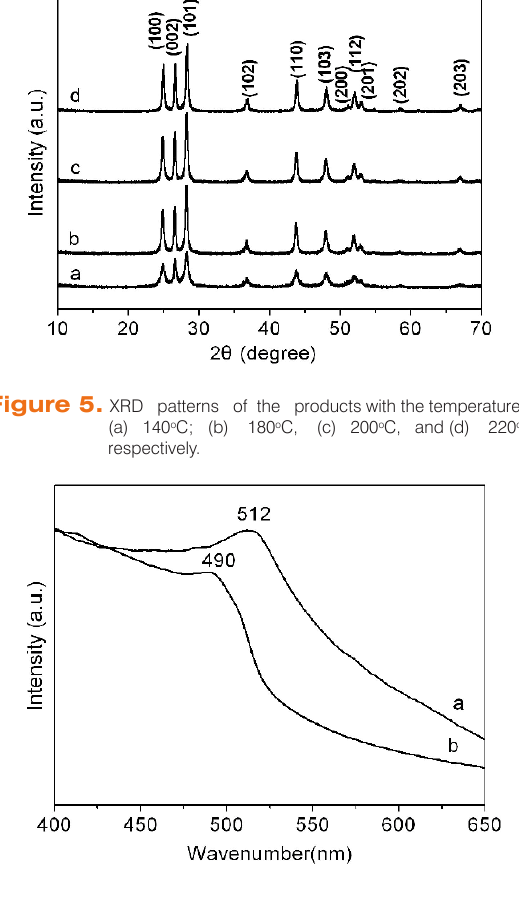
Figure 6. UV–vis absorption spectrum at room temperature: (a) bulk CdS; (b) the flower-like CdS architectures.